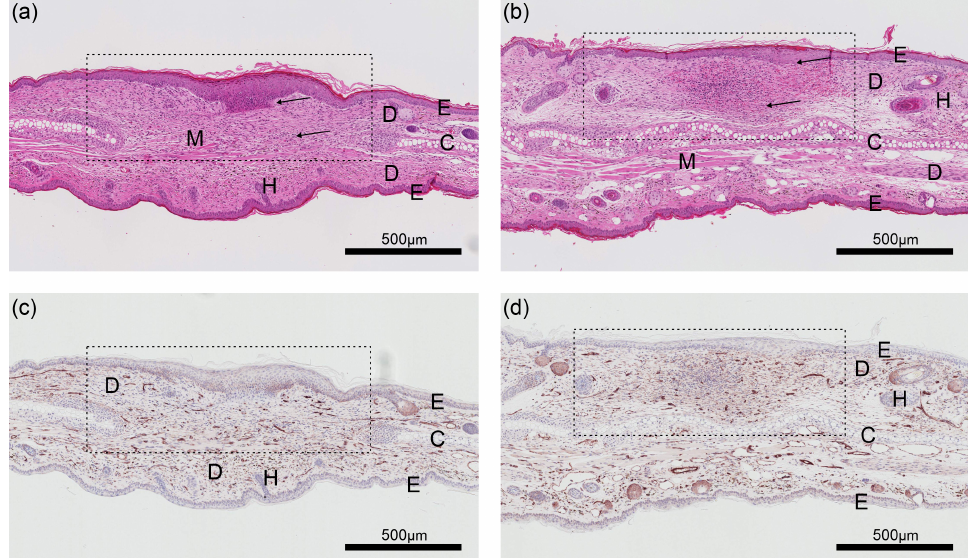
Figure 7. Example of cross-sectional histology of full thickness mouse pinnae on D18. Slices depict ( a , c ) non-diabetic and ( b , d ) diabetic mice in the control group stained with ( a , b ) HE or ( c , d ) anti-CD31 antibody, respectively. The dashed line rectangles indicate the respective wound area. Epidermis E, dermis D, muscle M, cartilage C, and hair follicles H. ( a ) In the HE staining in the non-diabetic mouse, the top arrow highlights the granulation process below the closed epithelium, while the bottom arrow indicates the healing response with ingrowing fibroblasts and inflammatory cells. ( b ) The HE staining in the diabetic mouse shows complete re-epithelialization of the wound (top arrow). The bottom arrow shows a diffuse mixed inflammatory process. The anti-CD31 antibody staining in ( c ) the non-diabetic and ( d ) the diabetic animal depict comparable CD31+ endothelial cells indicating